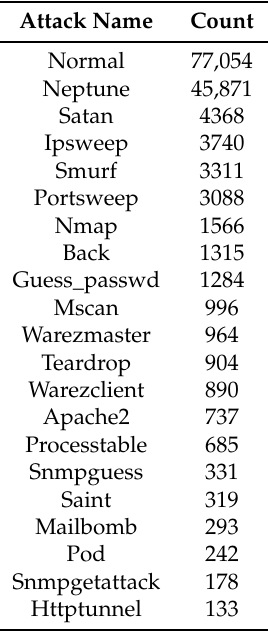
Table 6. Number of attacks used in this research for NSLKDD.